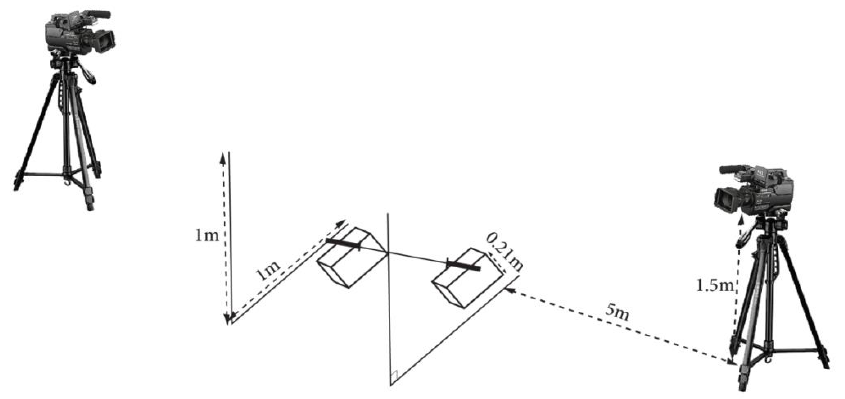
Figure 1. Placement of the cameras during the test sessions.